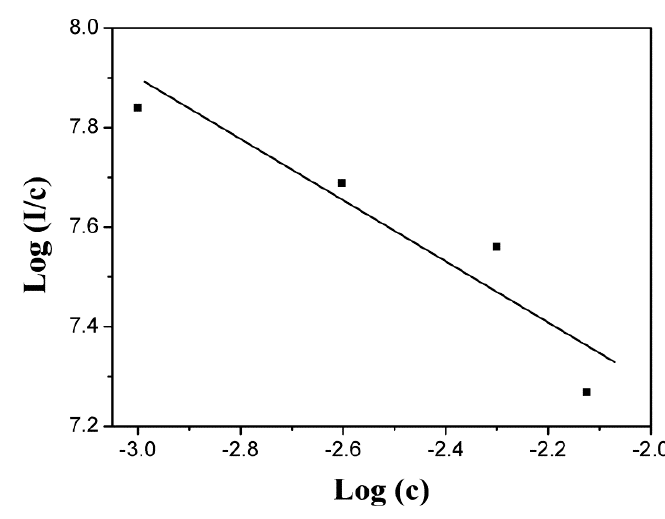
Figure 5. The relationship between log(I/c) and log(c) for the GOS:Pr phosphors.